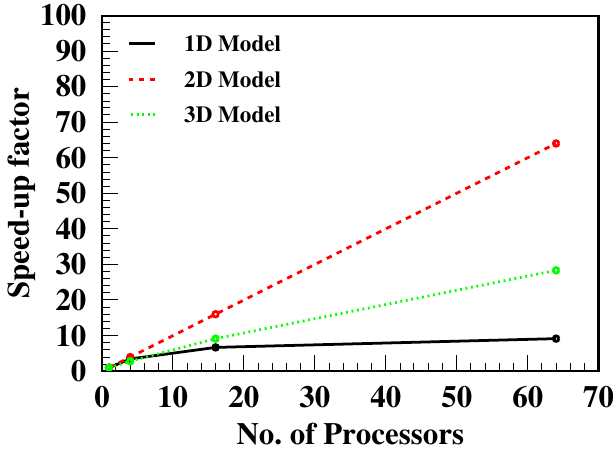
FIG. 4. (Color) Performance test results for 1D, 2D, and 3D domain decomposition models of the parallel Poisson solver on BG/L. Shown is the speedup factor as function of the number of processors. The calculations were performed on the same 128 (cid:3) 128 (cid:3) 256 SC grid.